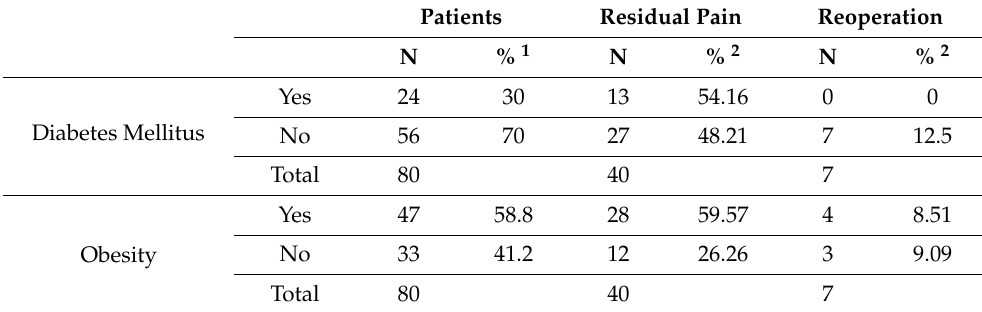
Table 3. Presence of residual pain and need for reoperation in relation to the presence of obesity or